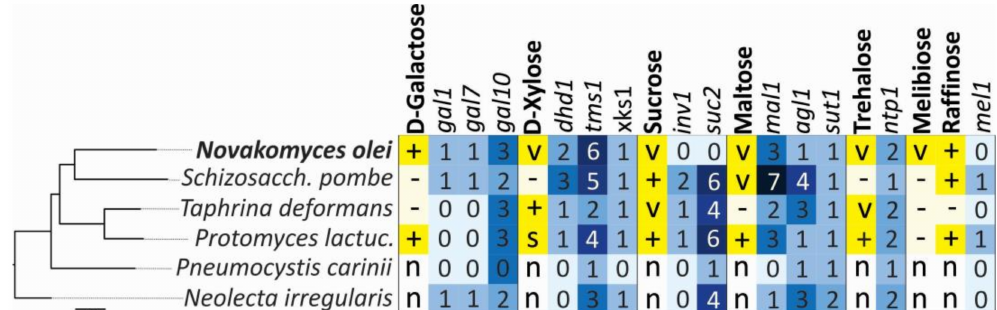
Figure 6. Correlation between assimilation profiles and gene content of Novakomyces olei and related species of Taphrinomycotina. Assimilation responses are represented by +, positive; − , negative; v, variable; s, slow; n, not determined (from Kurtzman et al. [82] and this study). Numbered boxes with blue colour intensity indicate the gene copy number determined by tBLASTn analyses. The maximum likelihood (ML) phylogeny was reconstructed under LG + GAMMA substitution model using RAxML. The scale bar presents amino acids substitutions per